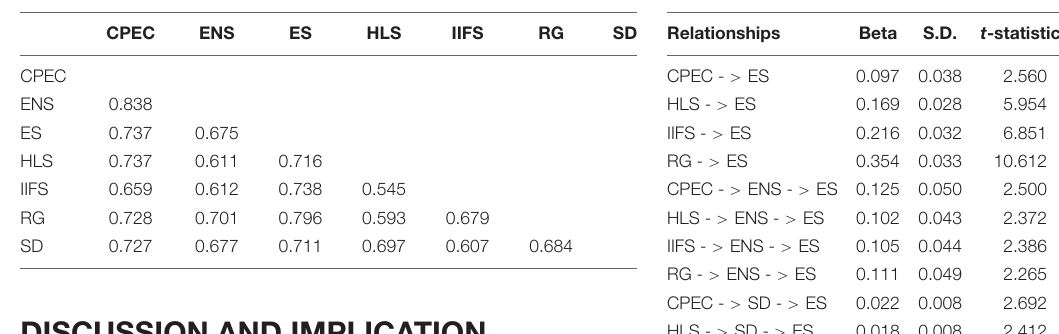
TABLE 4 | Heterotrait-Monotrait ratio.